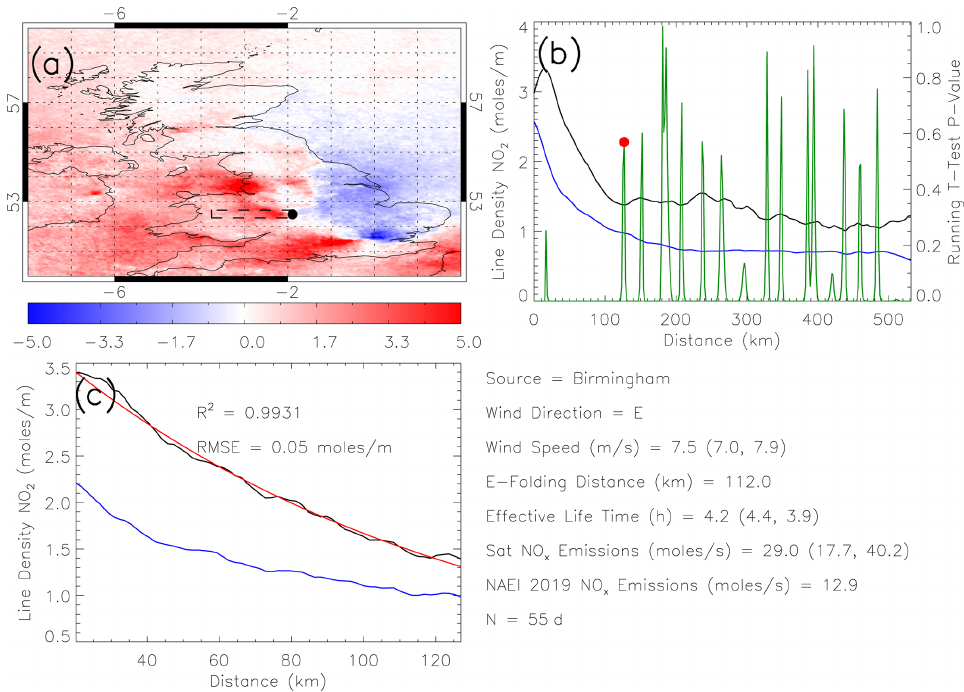
Figure 3. (a) TROPOMI TCNO 2 (10 − 5 molm − 2 ) sub-sampled under easterly flow (defined over Birmingham, black dot) minus the long- term average (February 2018 to January 2020). The dashed box represents the width of the source and distance between the source and background. (b) Downwind NO 2 LD from Birmingham (black: easterly flow, blue: all-flow average) with the corresponding running t -test p -value (green line). The red dot represents the location of the background level determined by the turning point in the running t -test p -value time series. (c) The easterly flow and all-flow NO 2 LD between the peak easterly flow NO 2 LD value and the background value. The red line represents the e -folding distance fit with the corresponding R 2 and RMSE between the easterly flow NO 2 LD and fit profile. N represents the number of days classified under easterly flow over